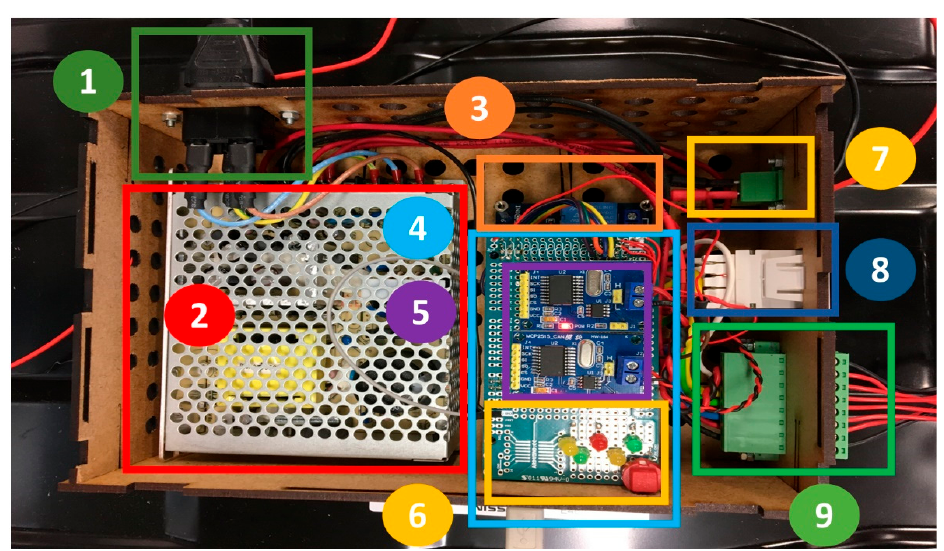
Figure 7. Picture of the LD. 1 — Electrical socket; 2—power supply; 3—Arduino 4 Relay Board; 4 — Arduino MEGA; 5—two CAN-BUS Shields v.1.2; 6—LEDs and button; 7—HV relay control; 8—